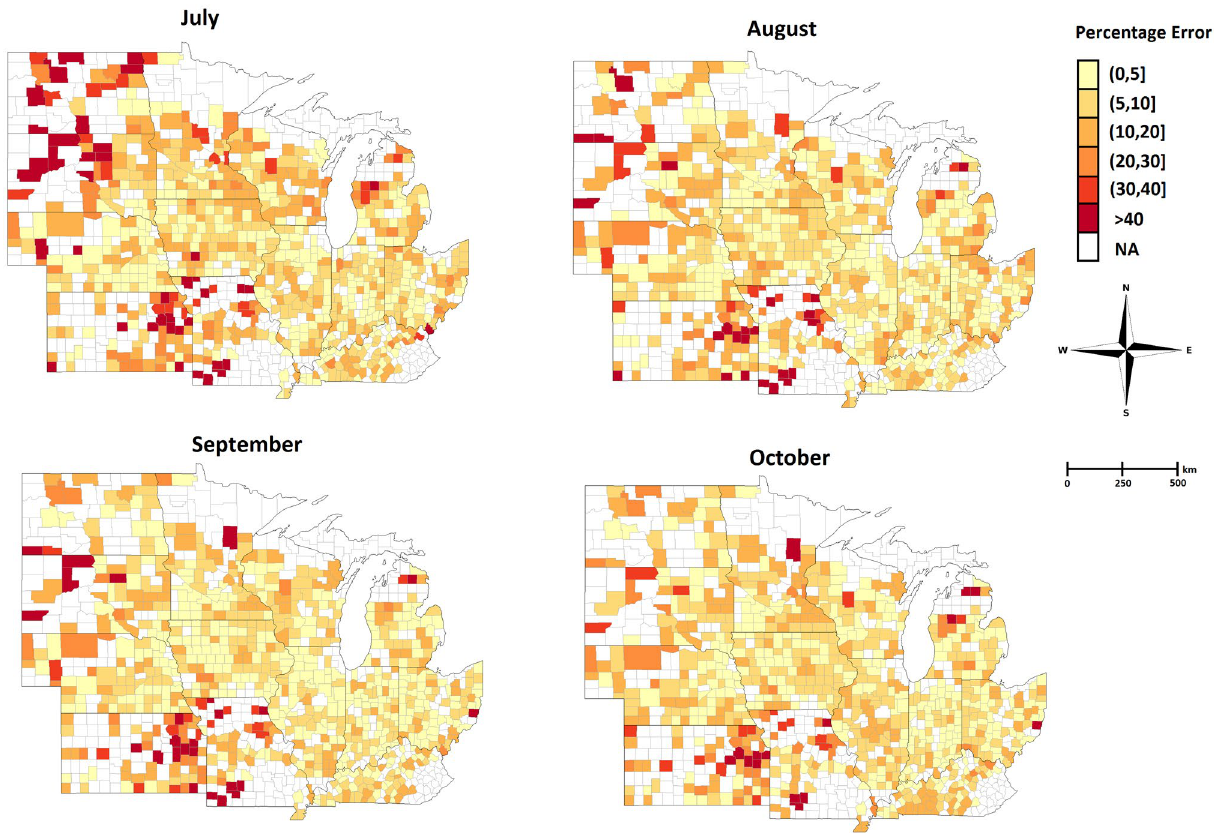
Figure 5. The error percentage maps for the 2018 corn yield prediction which is done during growing season in July, August, September, and October. The counties with white color indicate the ground truth yield were not available for those counties in